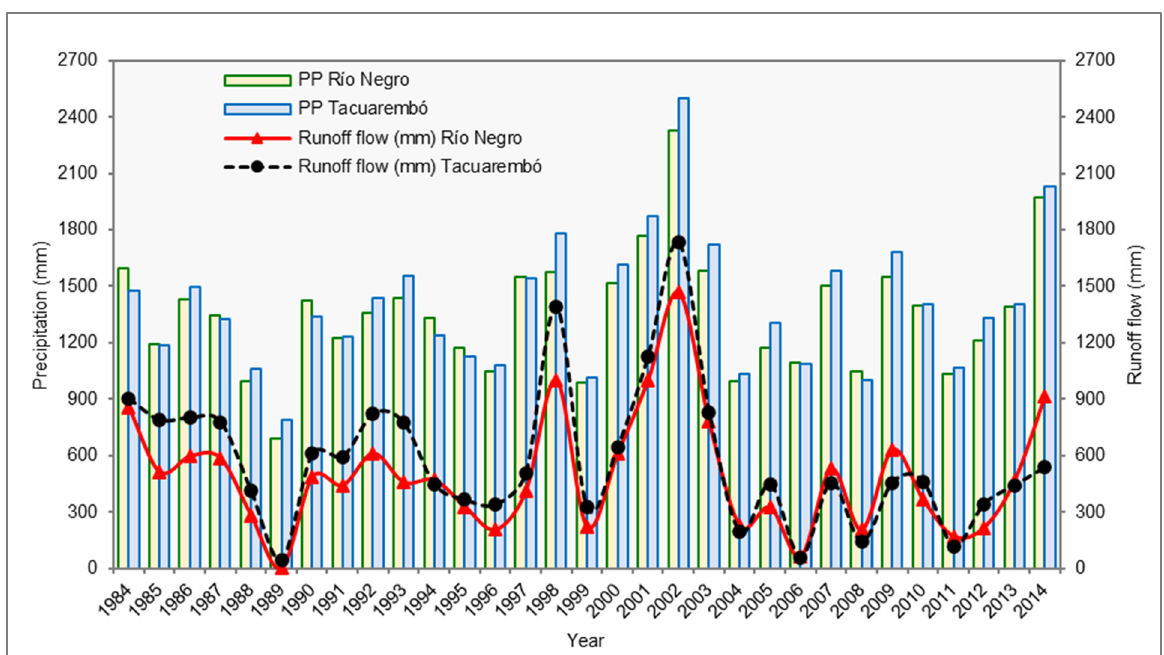
Figure 7. Precipitation regime and interannual runoff flow in the period 1984–2014 of the two basins under study. The bars are the average accumulated precipitation. The black line (Tacuarembó Basin) and the red line (Río Negro Basin) correspond to the cumulative runoff flow in mm from the Paso del Borracho and Paso Aguiar monitoring stations, respectively.